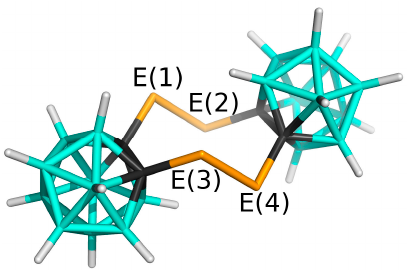
Figure 1. Molecular diagram of the Se 4 C 4 and Te 4 C 4 molecules that contain two icosahedral moieties connected by chalcogen bridges. The atom color coding is as follows: cyan—B; black—C; orange—E (E = Se, Te); white—H.